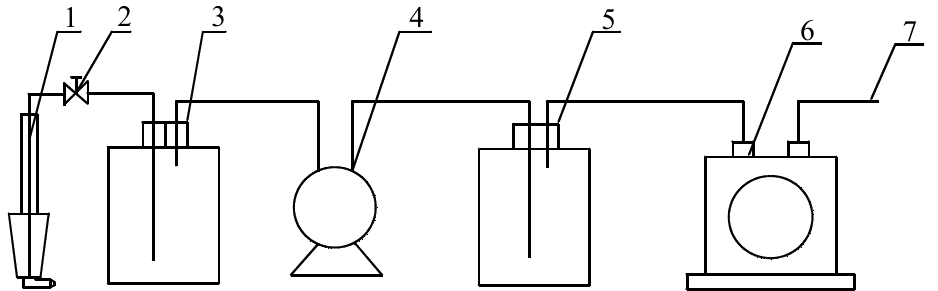
Figure 2. Sampling system. 1. Sampling tube. 2. Needle valves. 3. Dry bottles. 4. Pumping Pump. 5. Buffer bottles. 6. Wet gas flow meter. 7. Discharge tube.